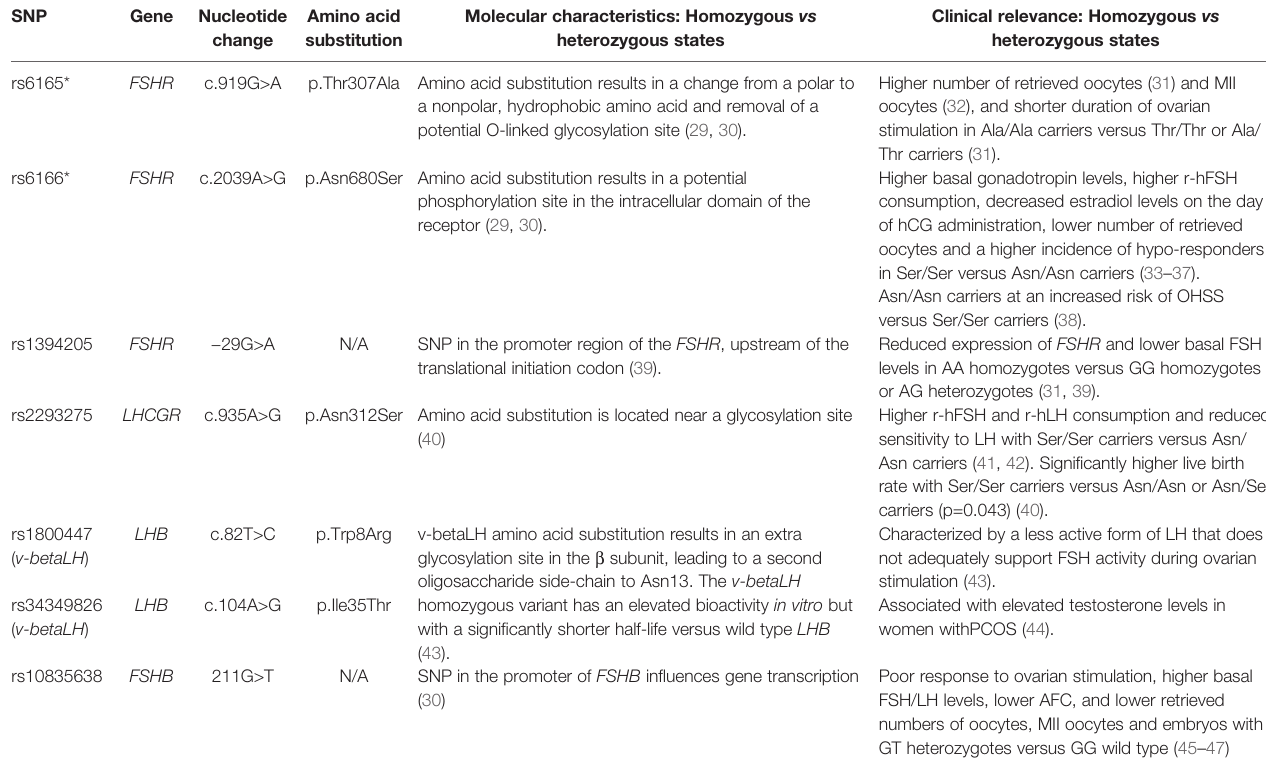
Clinical relevance: Homozygous vs heterozygous